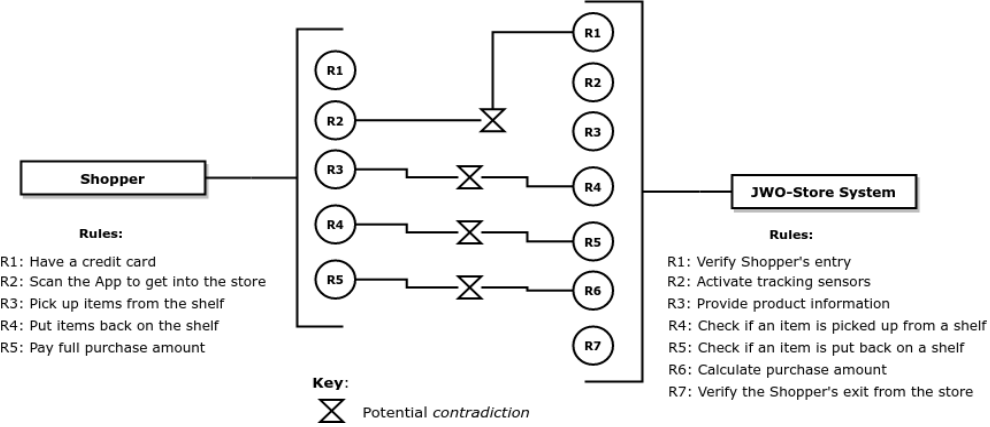
Figure 4. Representation of the NoA for the scenario proposed (simplified form).